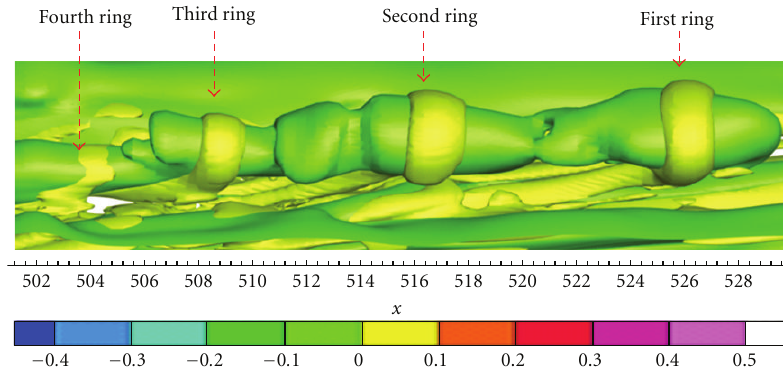
Figure 16: Three-dimensional momentum deficit and multiple ring-like vortex formation.